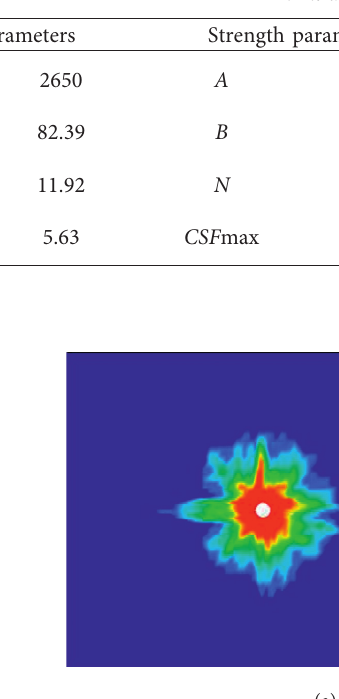
Table 4: Related parameters of the rock material JHC.